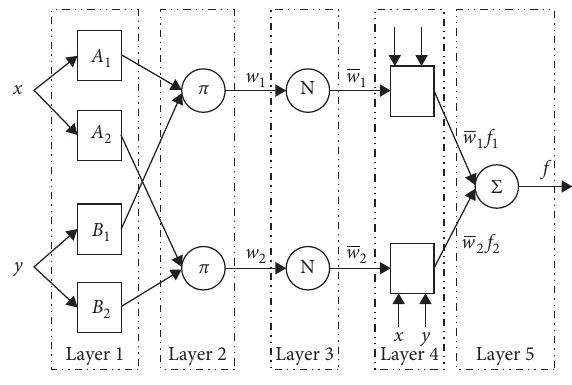
Figure 3: ANFIS with a two-input-two-rule structure [38].